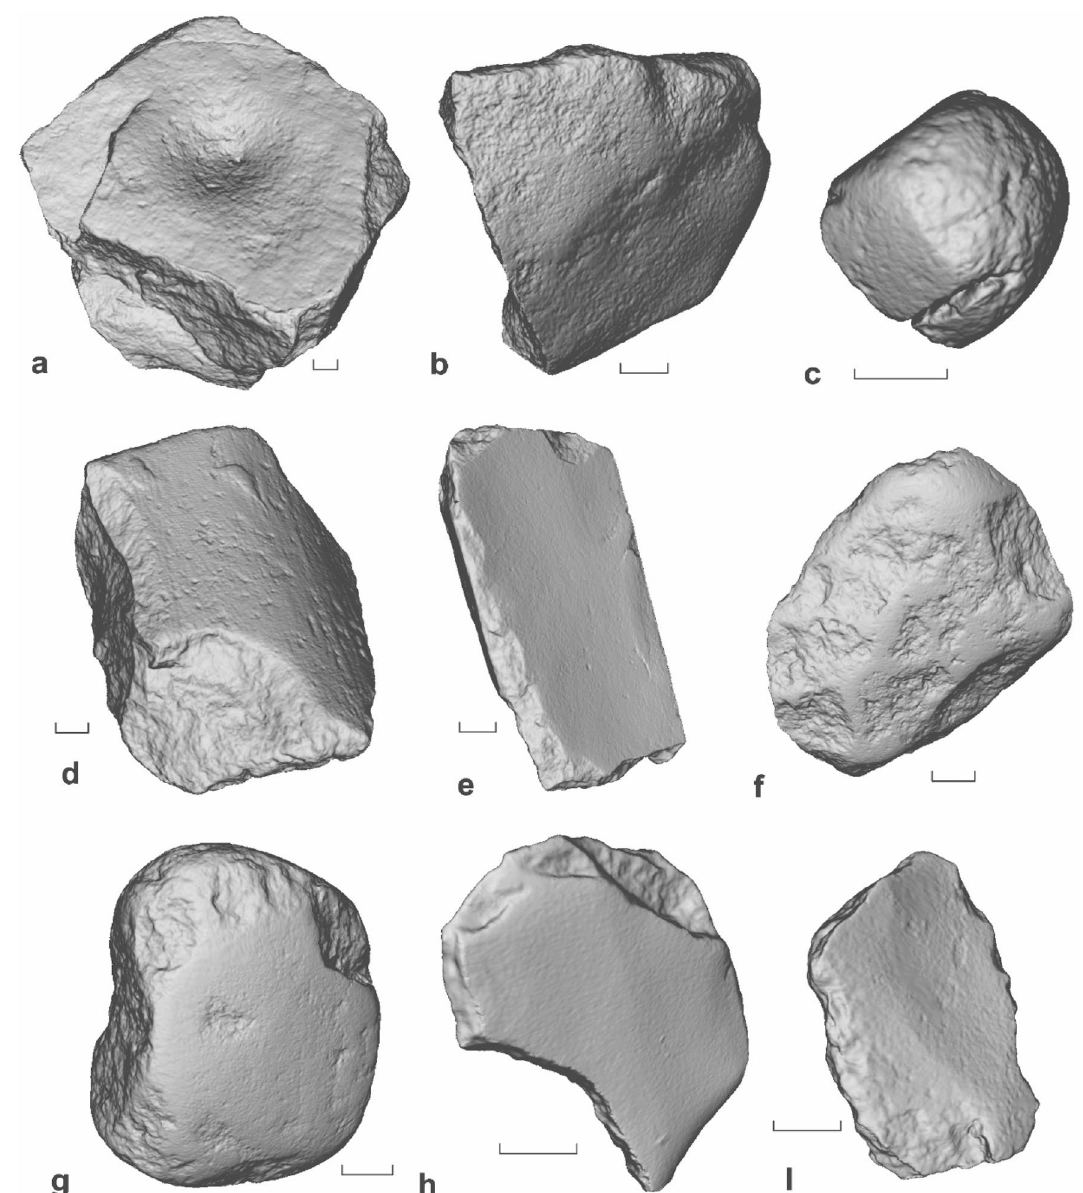
Figure 2. 3-D scans of grinding stones from Madjedbebe. ( a ) GS32, C2-C3/37, Phase 2, mortar; ( b ) GS20, E1/27, Phase 4, filing stone; ( c ) UPGS26, C3/35, Phase 3, pounding stone fragment; ( d ) GS73, B5/52, Phase 2, millstone fragment; ( e ) GS79, B6/54, Phase 2, whetstone. ( f ) L49, C2/5, Phase 7, upper hand stone; ( g ) L52, C3/5, Phase 7, upper hand stone; ( h ) GS36, C1/35, Phase 2, tabular fragment; ( i ) GS50, C4/45, Phase 2, tabular fragment. Scale bars are 2